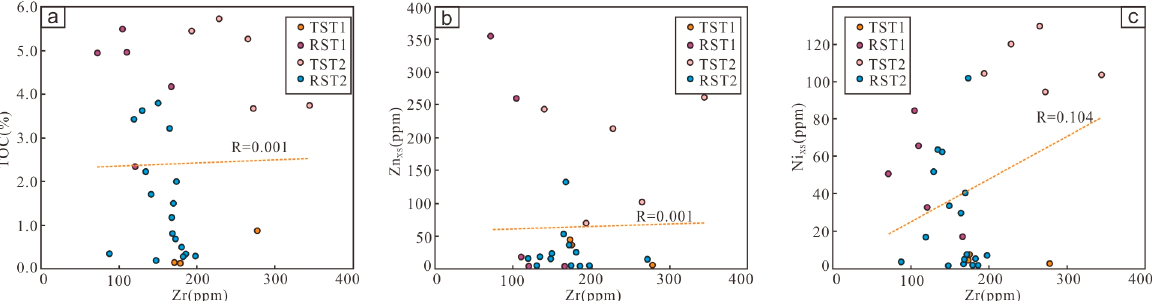
Figure 8. Crossplots of Zr vs. ( a ) TOC, ( b ) Zn xs , and ( c ) Ni xs of samples from Well